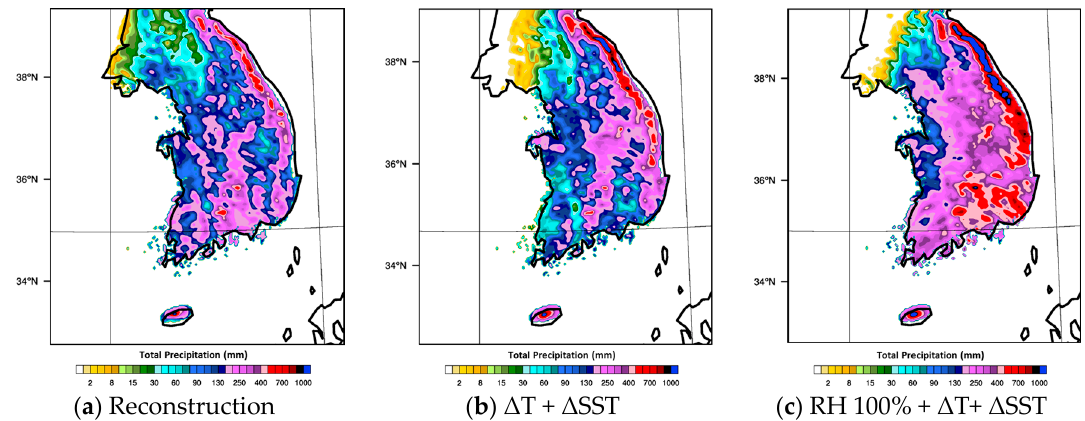
Figure 6. Comparison of total spatial precipitation according to maximization scenarios.